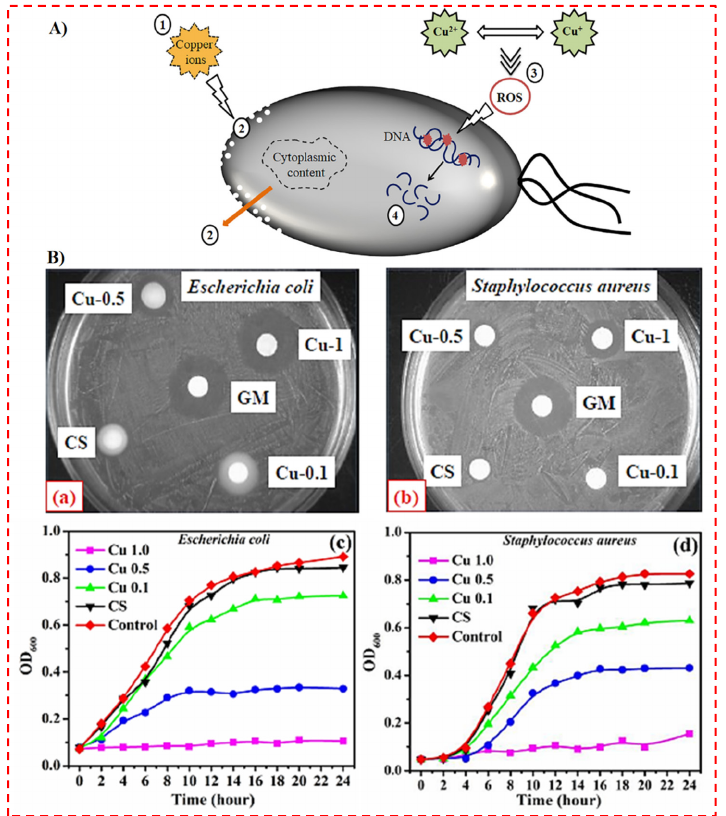
Figure 2. ( A ) The schematic illustration of the killing action involved in the antibacterial activity of copper. Copper ions are released from the doped biomaterial (1) and cause membrane damage leading to a loss of cytoplasmic content (2). Then, the production of reactive oxygen species (ROS) (3) causes DNA fragmentation (4) and cell death [26]. ( B ) Inhibition zone against ( a ) E. coli and ( b ) S. aureus , growth inhibition curve in TGY broth against ( c ) E. coli and ( d ) S. aureus [50].